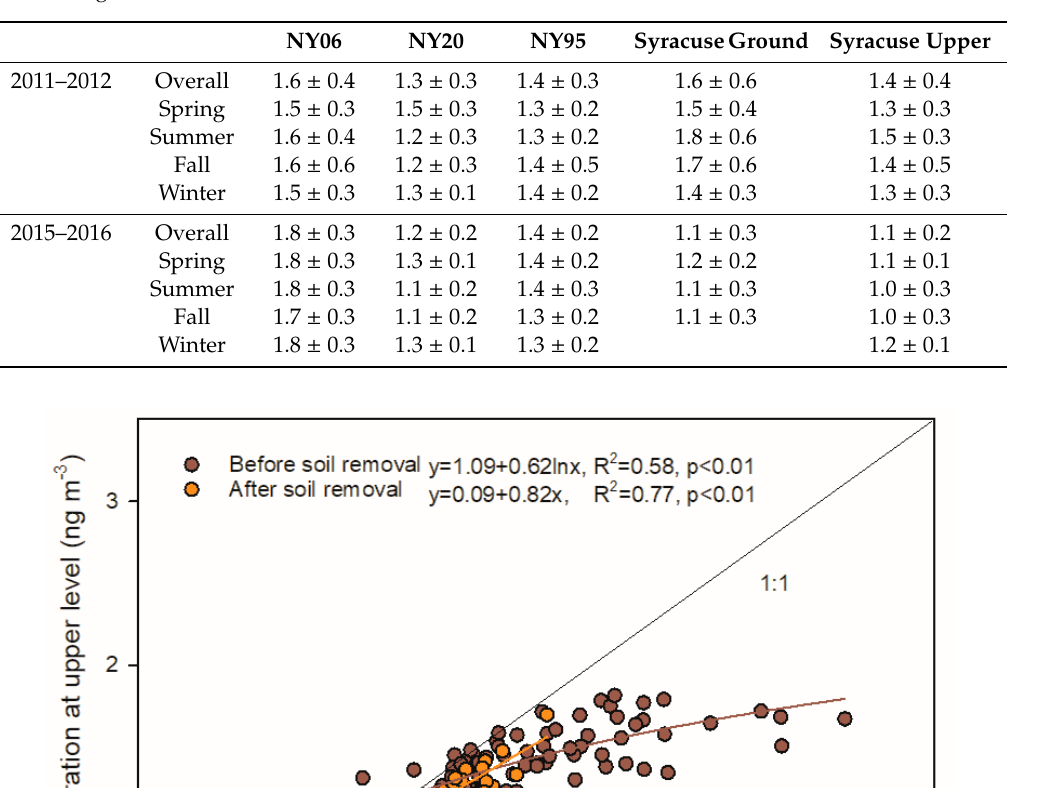
Table 1. Annual mean and standard deviation of TGM concentration for Syracuse Center of Excellence (CoE) and AMNet sites in New York State (in ng · m − 3 ). NY06 is located in Bronx, NY; NY20 is located at Huntington Forest, NY; NY95 is located in Rochester, NY.